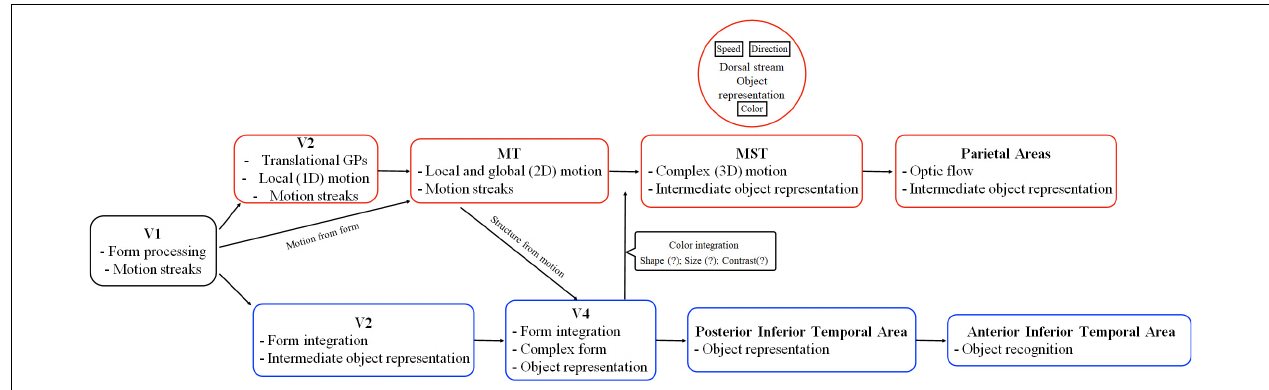
FIGURE 3 | Schematic representation of the ventral and dorsal stream functions according to state of the art starting from V2. The red boxes report some areas and functions of the dorsal stream, where-as the blue boxes report areas and functions of the ventral stream. Adapted from Perry and Fallah (2014).